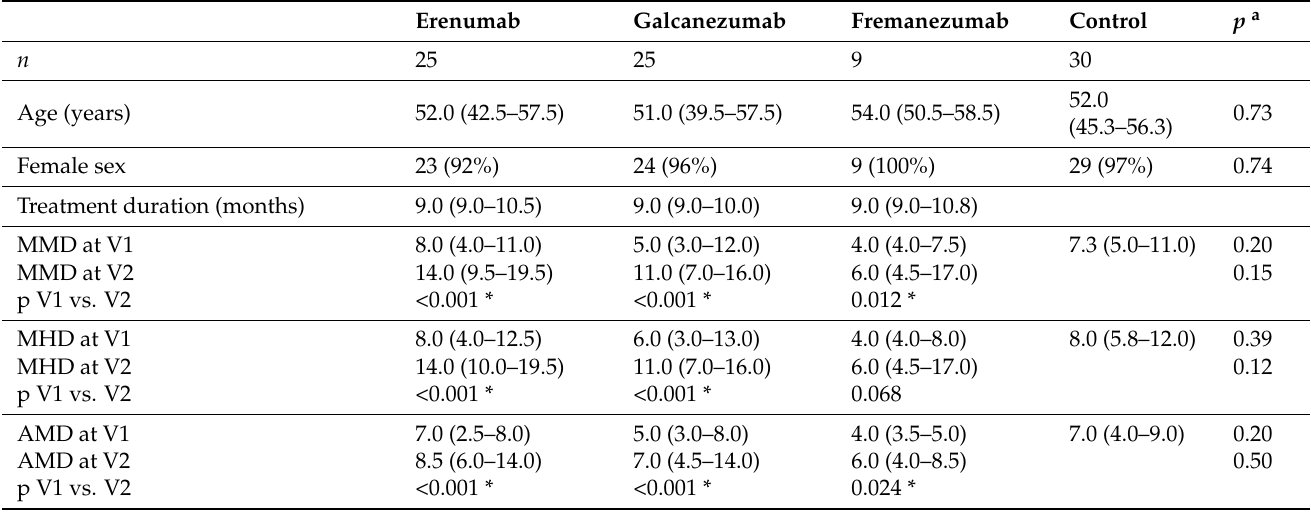
Table 1. Demographic and headache characteristics of study participants at the time of the last mAb injection (V1) and after 16 weeks (V2). Erenumab